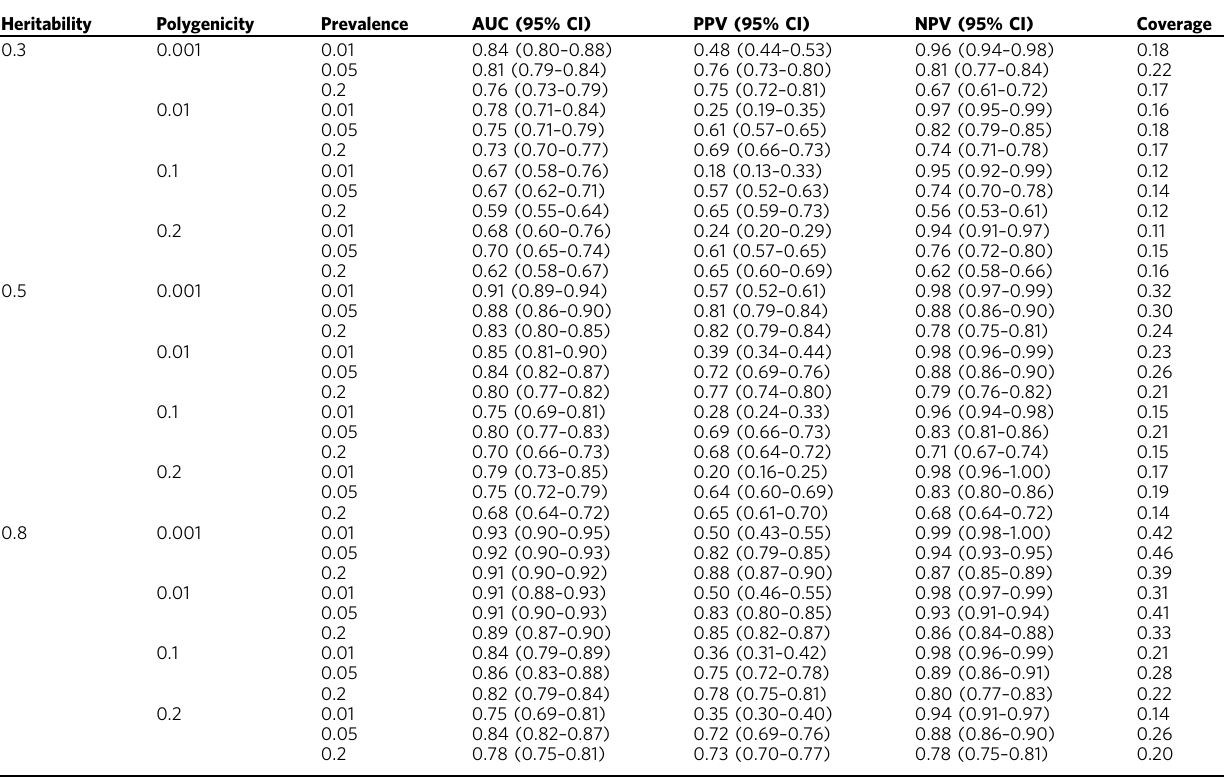
Table 1 Performances of Mondrian cross-conformal prediction at an error of 0.05 on various genetic architecture by simulation (proportion of discovery set for GWAS is 0.5).